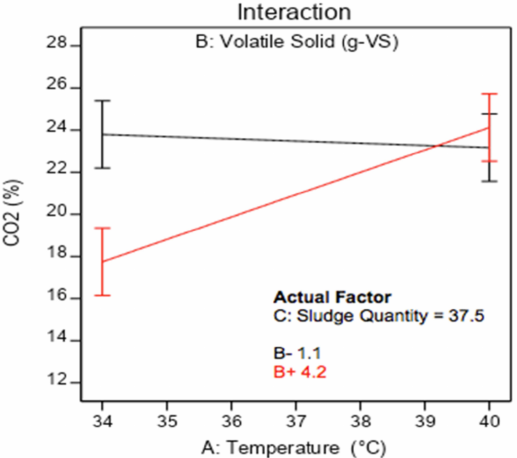
Figure 15. Interaction plot illustrates the effect of interaction between temperature and volatile solid on CO 2 %.